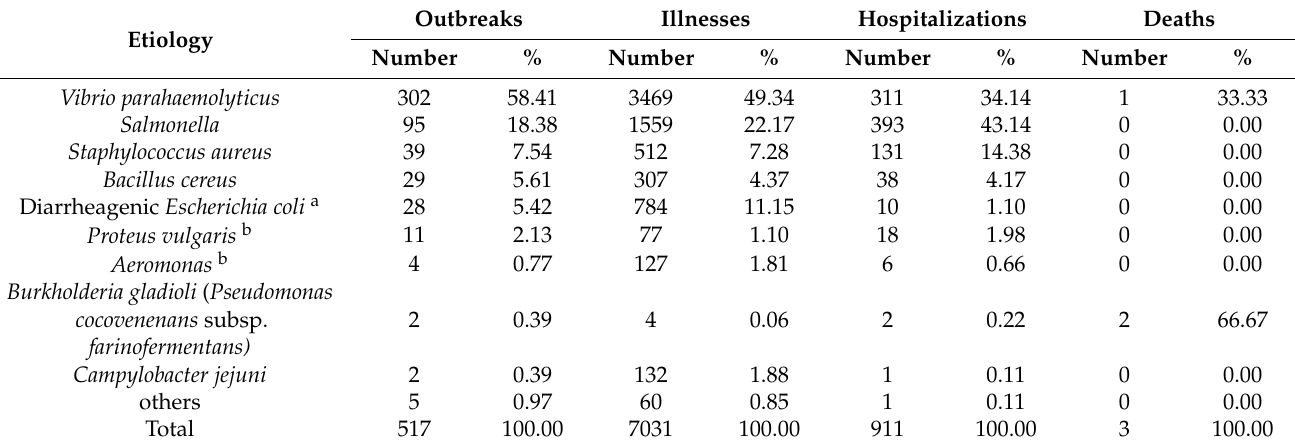
Table 2. Etiological distribution of bacterial FBDOs in Zhejiang Province from 2010 to 2020.